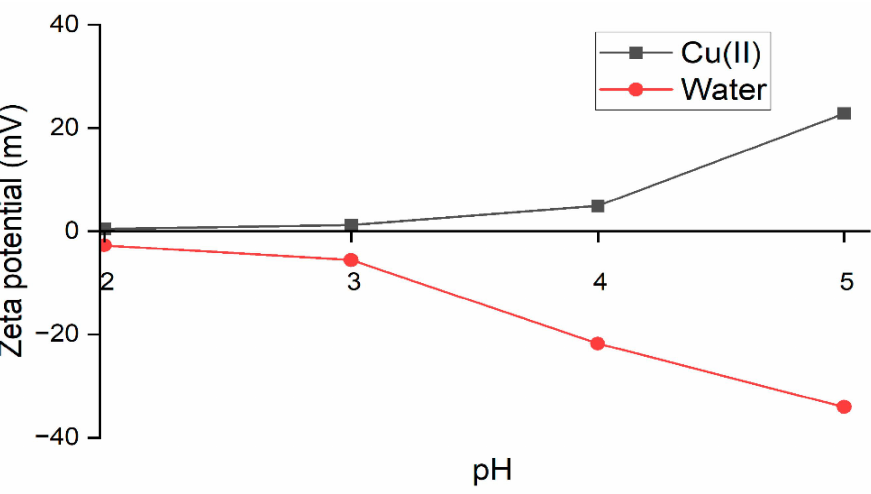
Figure 5. Zeta potential (mV) on JPU/GO 0.50 wt% membrane at different pH in distilled water and in Cu(II) ions